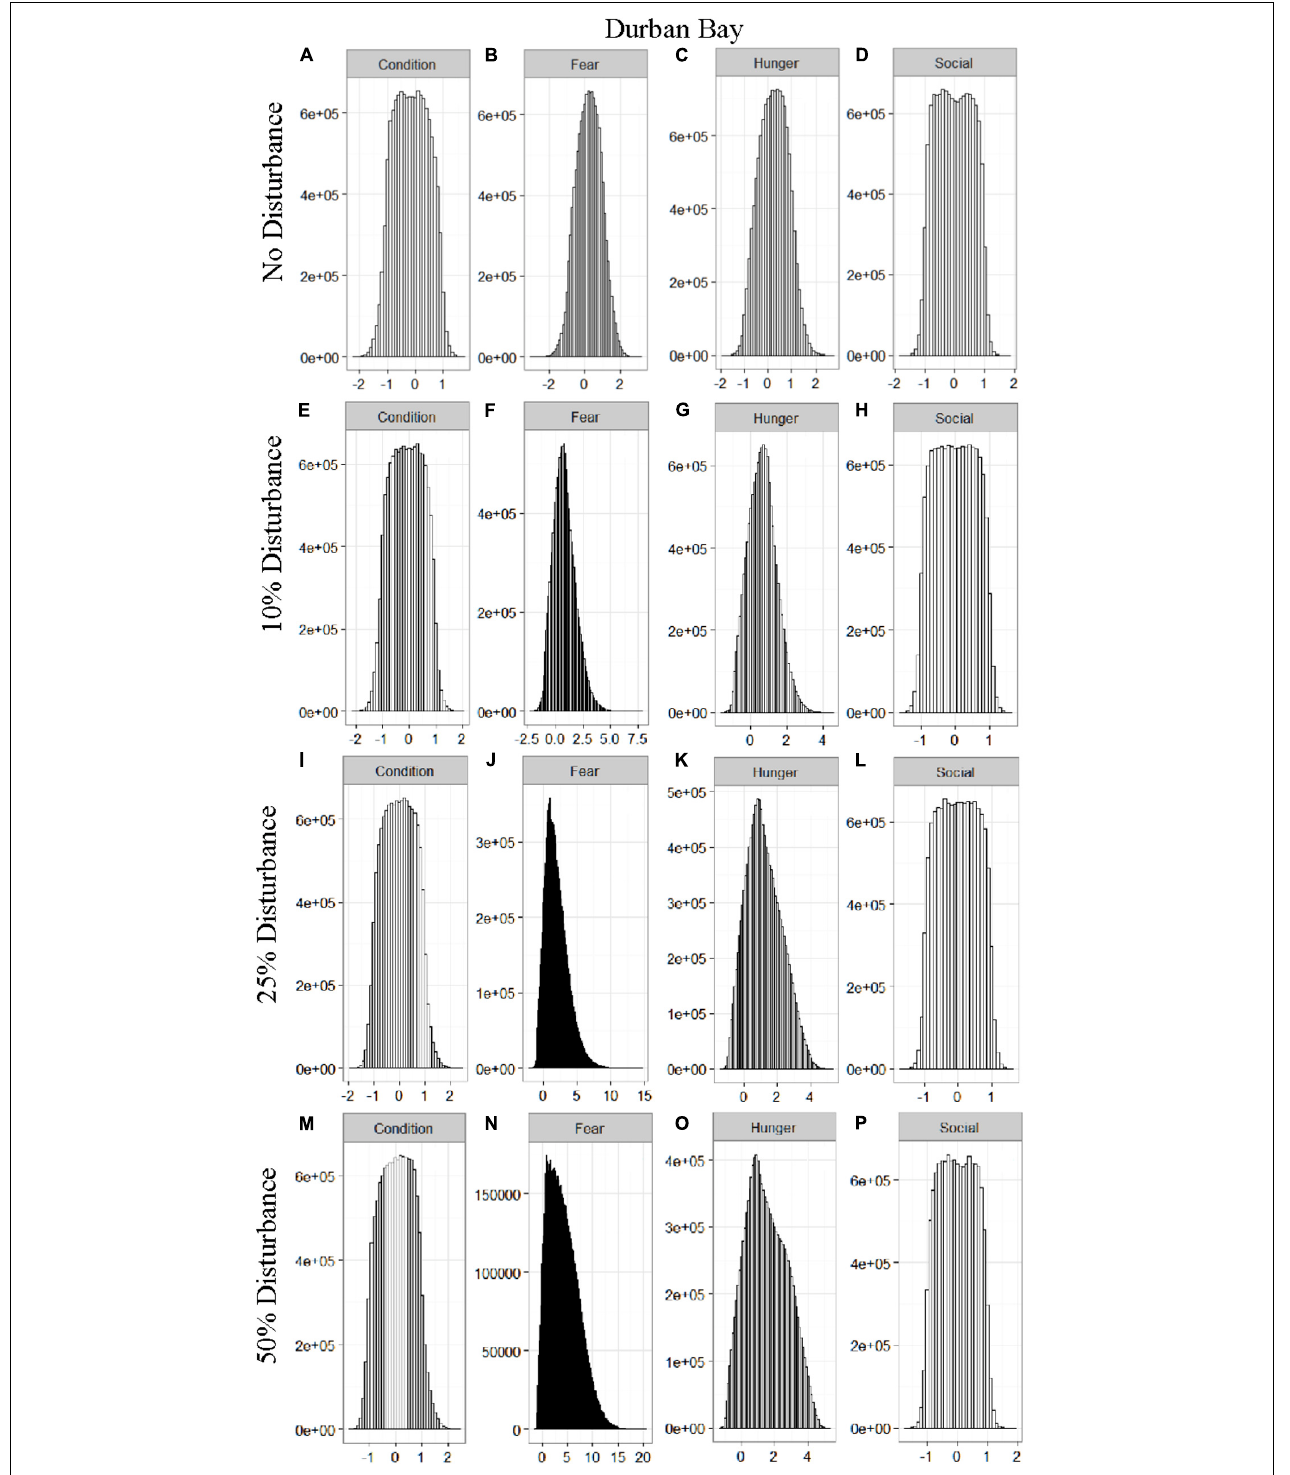
FIGURE 5 | The four motivational states of condition (A,E,I,M) , fear (B,F,J,N) , hunger (C,G,K,O) , and social need (D,H,L,P) for the simulated Durban Bay population under each of the four disturbance scenarios: no disturbance (A–D) and a 10% (E–H) , 25% (I–L) , or 50% (M–P) chance of an individual being disturbed when in the area used by whale-watching vessels. The y -axis is the cumulative count over all simulations, while the x -axis is a unit-less measure of individual motivation. Motivation is centered at zero (i.e., indifference) and can take on negative values to indicate a lack of incentive (i.e., satisfaction) and positive values to indicate strong incentive (i.e., discontent) (New et al.,